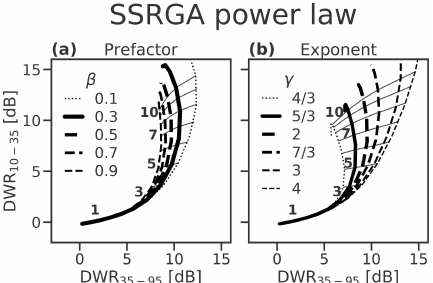
Figure 1. Forward-modelled triple-frequency radar signatures for fractal particles represented by the SSRGA, with a range of values of (a) the power law prefactor β , where the exponent is constant ( γ = 2 . 0), and (b) the power law exponent γ , where the prefactor is constant ( β = 0 . 55). The other SSRGA parameters used are for the aggregates of bullet rosettes of Hogan et al. (2017), given in Ta- ble 1. Lateral lines denote increments of median volume diameter, labelled in millimetres. All particles are assumed to have an expo- nential PSD ( µ = 0), a density factor of r = 0 and a particle axial ratio of AR = 0 .